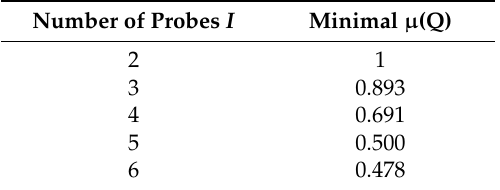
Table 1. Minimal two-sided coherence of matrix Q ( L =